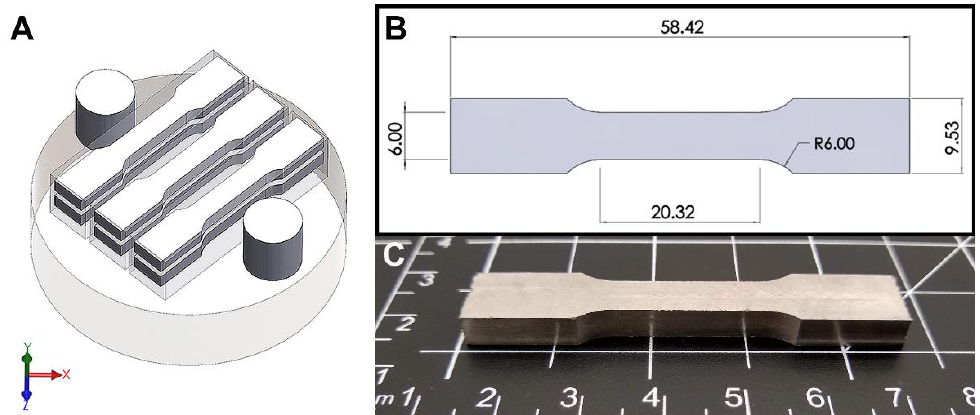
Figure 2. Illustration of the orientation and layout of samples on the CP-Ti substrate. ( A ) Tensile bar geometries and locations harvested by EDM are shown overlayed on the blocks that were produced. ( B ) Drawing showing the dimensions of the ASTM E8 Subsize tensile specimen and ( C ) a photograph of a finished tensile specimen. All dimensions in mm.